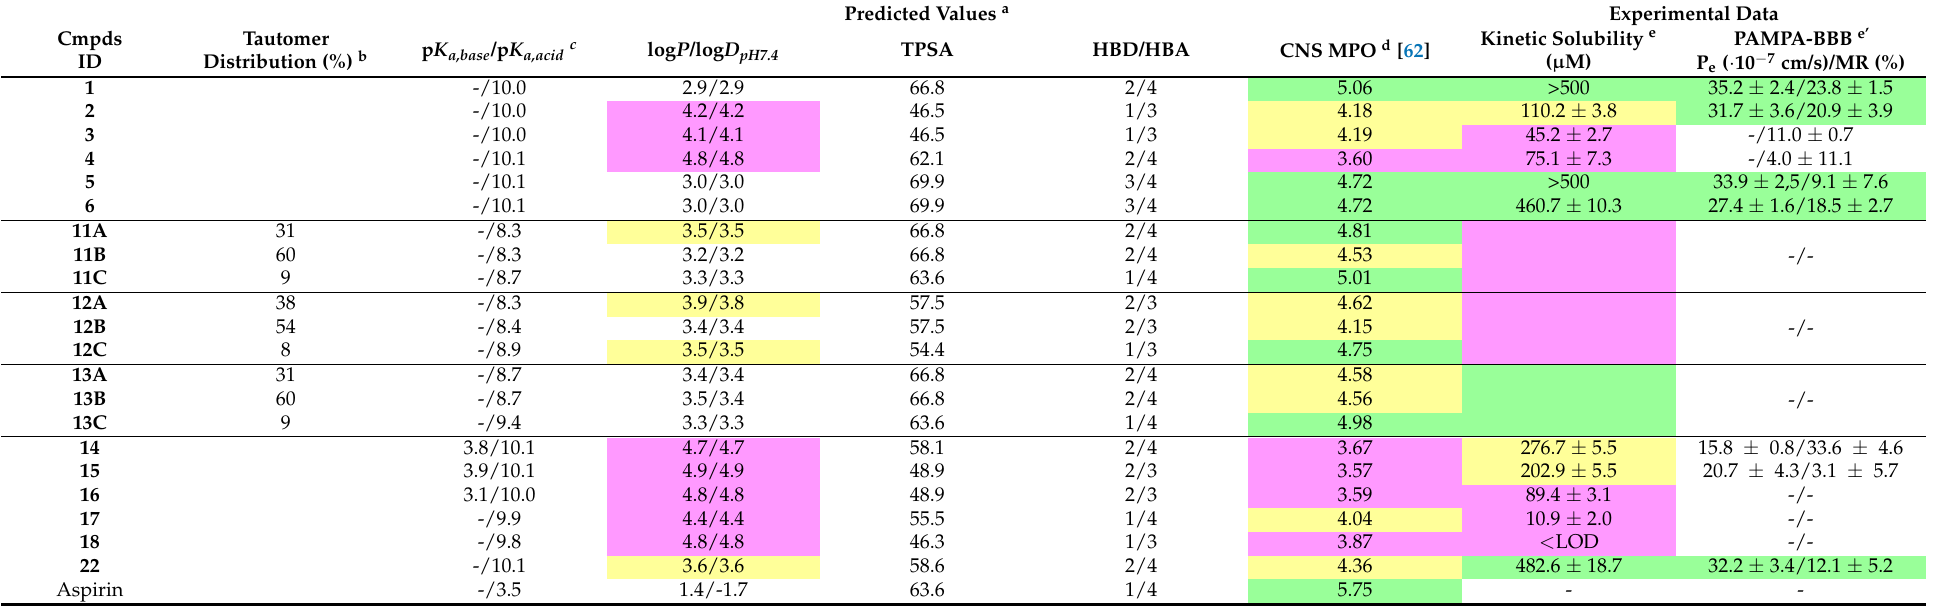
Table 1. In silico and experimental data for physicochemical and BBB permeability characterisation. Results are given as mean ± standard error of the mean (SEM); n = 3.